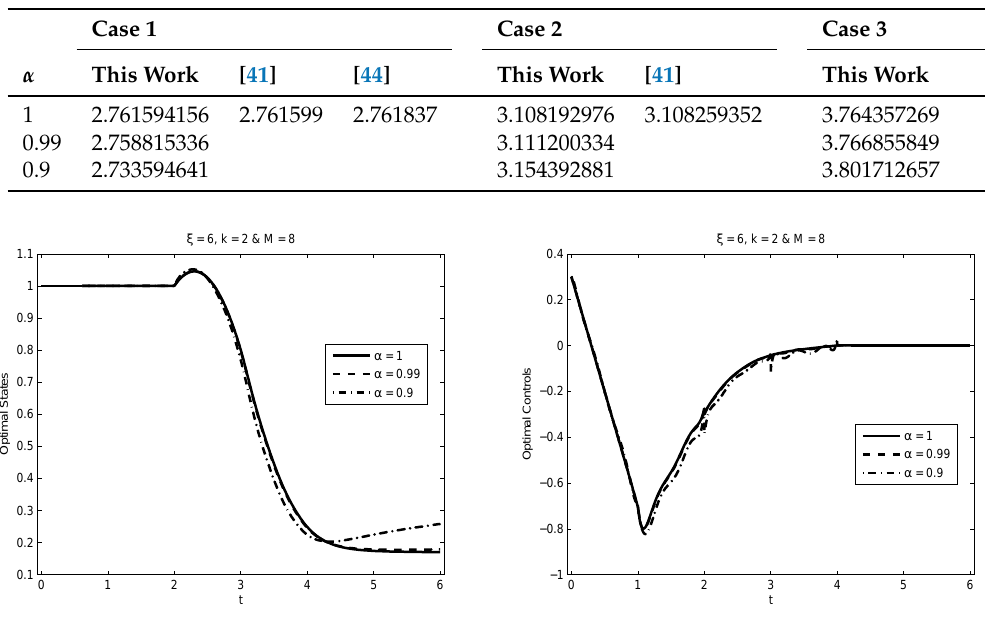
Figure 7. Optimal states and controls for Example 7, Case